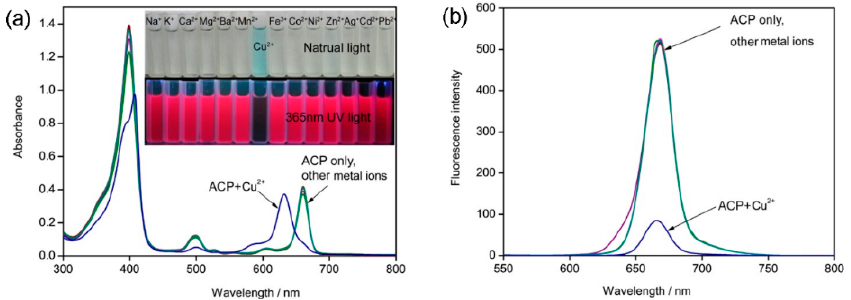
Figure 3. ( a ) UV-Vis absorption and ( b ) fl uorescence emission spectra of ACP (10 µM) upon addition of various metal ions (10 µM) in water/ ethanol ( v / v = 50/50) solution. The color changes of ACP (10 µM) upon addition 1 equiv. of various metal ions under natural light and UV-Vis are also displayed. Molecules 2016 , 21 , 107